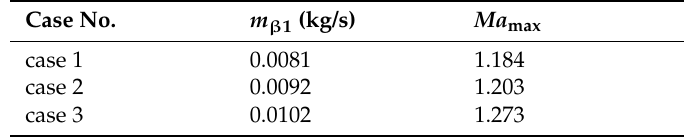
Table 4. The maximum Mach numbers at different steam inlet mass flow rates. Case